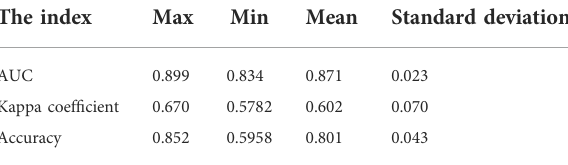
TABLE 5 Training results of common DBN model (30